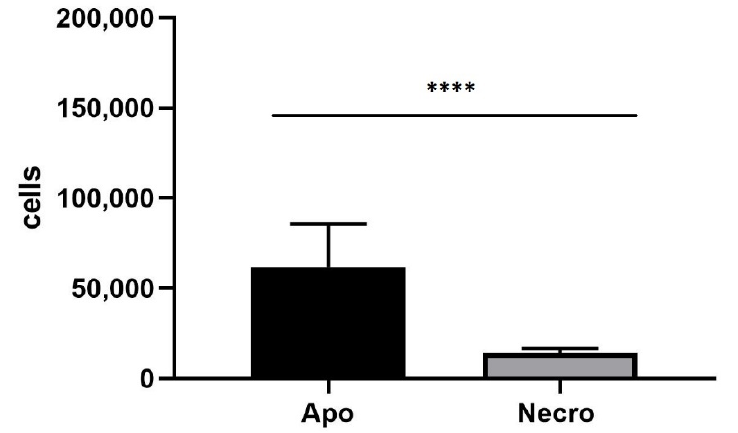
Figure 8. Annexin/PI on neural spheroids without 1.5mM MPP + . The number of apoptotic cells is higher compared to necrotic cells. The graph shows the means ± SEM of three experiments. Statistical analysis was performed through the analysis of variance (ANOVA) and the Dunnet’s post-test. The differences were considered significantly between apoptotic and necrotic cells. **** p < 0.01.